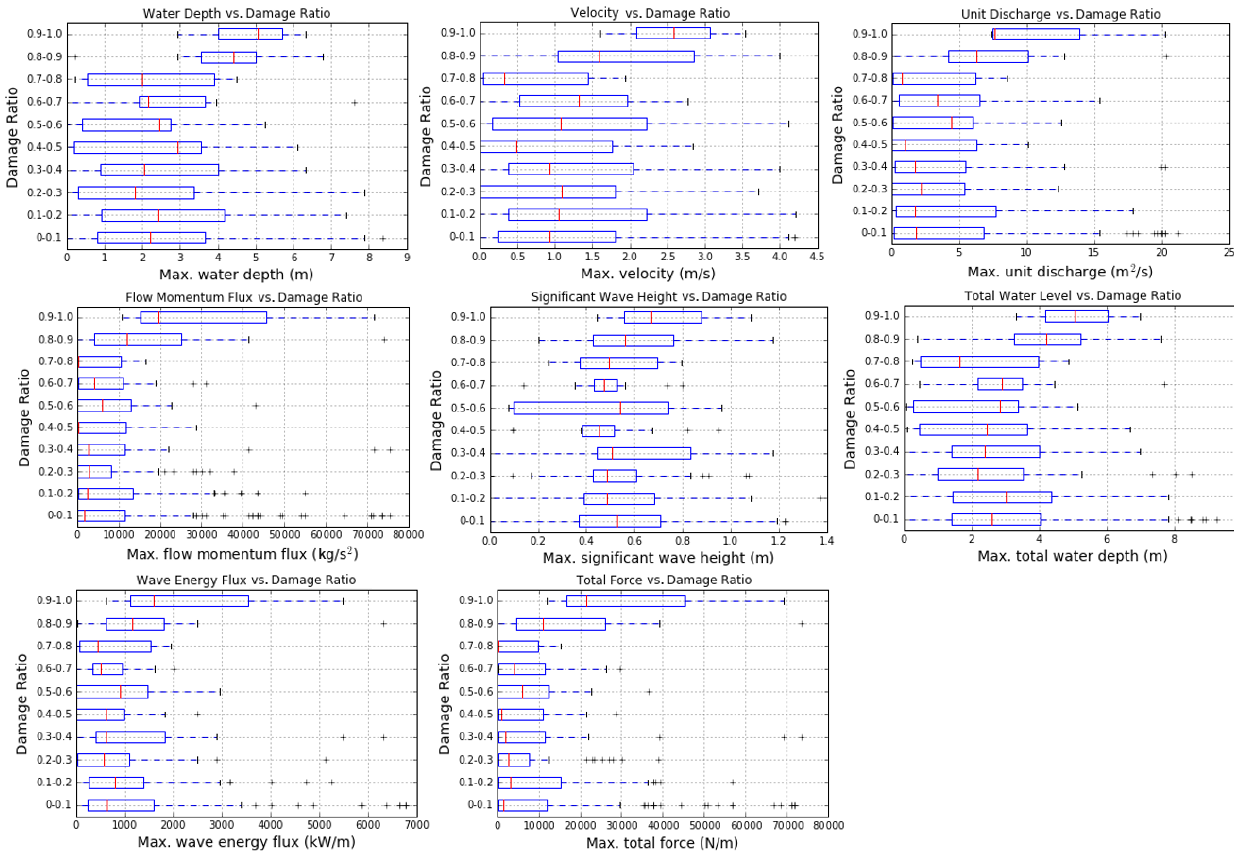
+ ρhv 2 ) with the IGN DEM. C g